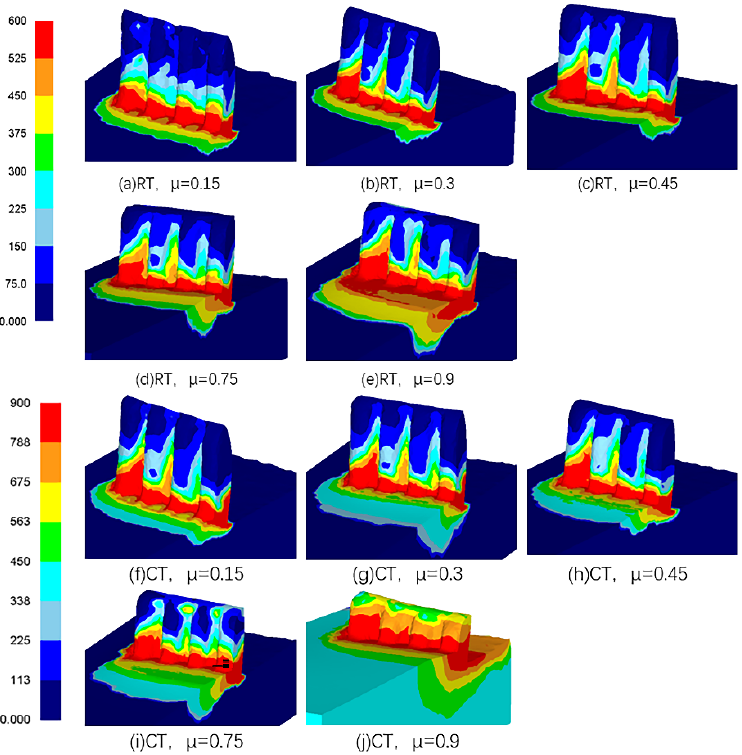
Figure 16. Effective stress distribution of the fins under different conditions.